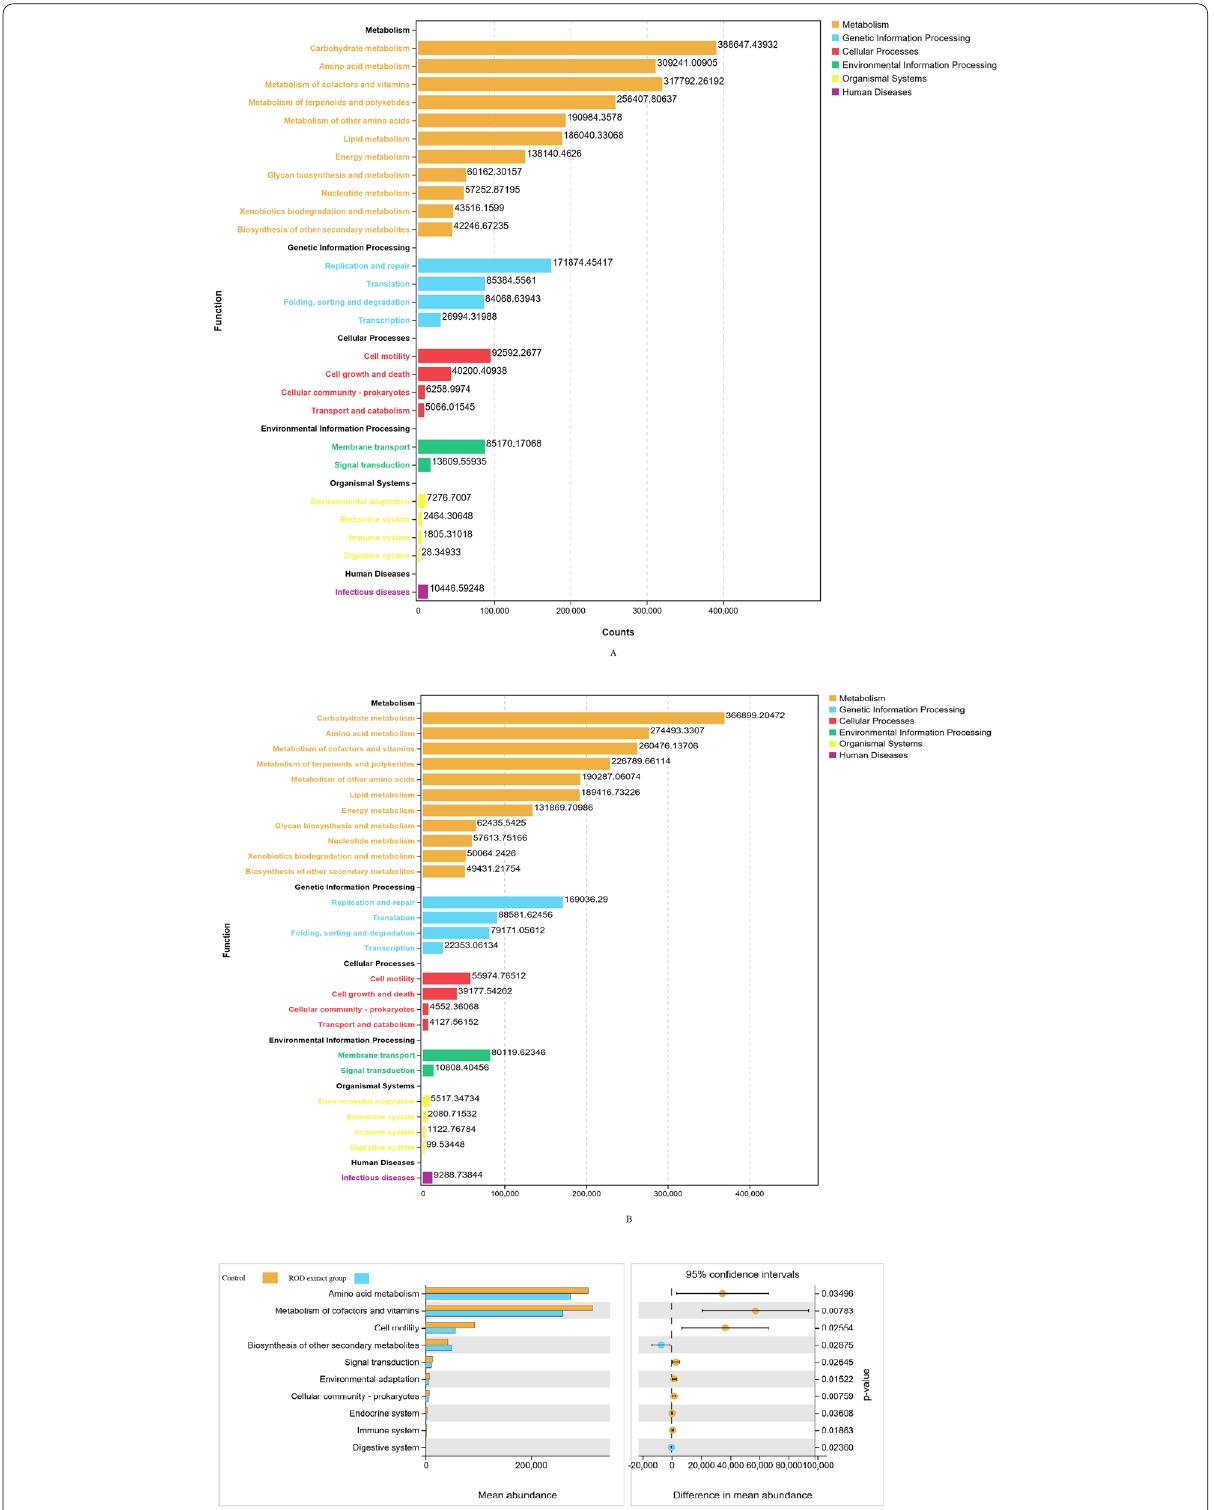
Fig. 4 Functional diversity of ileal bacterial community of control ( A ) and ROD polyphenol extract group ( B ). Function predictions were performed by using PICRUSt 2. Functional difference between control and ROD polyphenol extract group, and only the abundances of KEGG pathways of ileal microbiota that were significantly influenced by ROD polyphenol extract are shown ( C